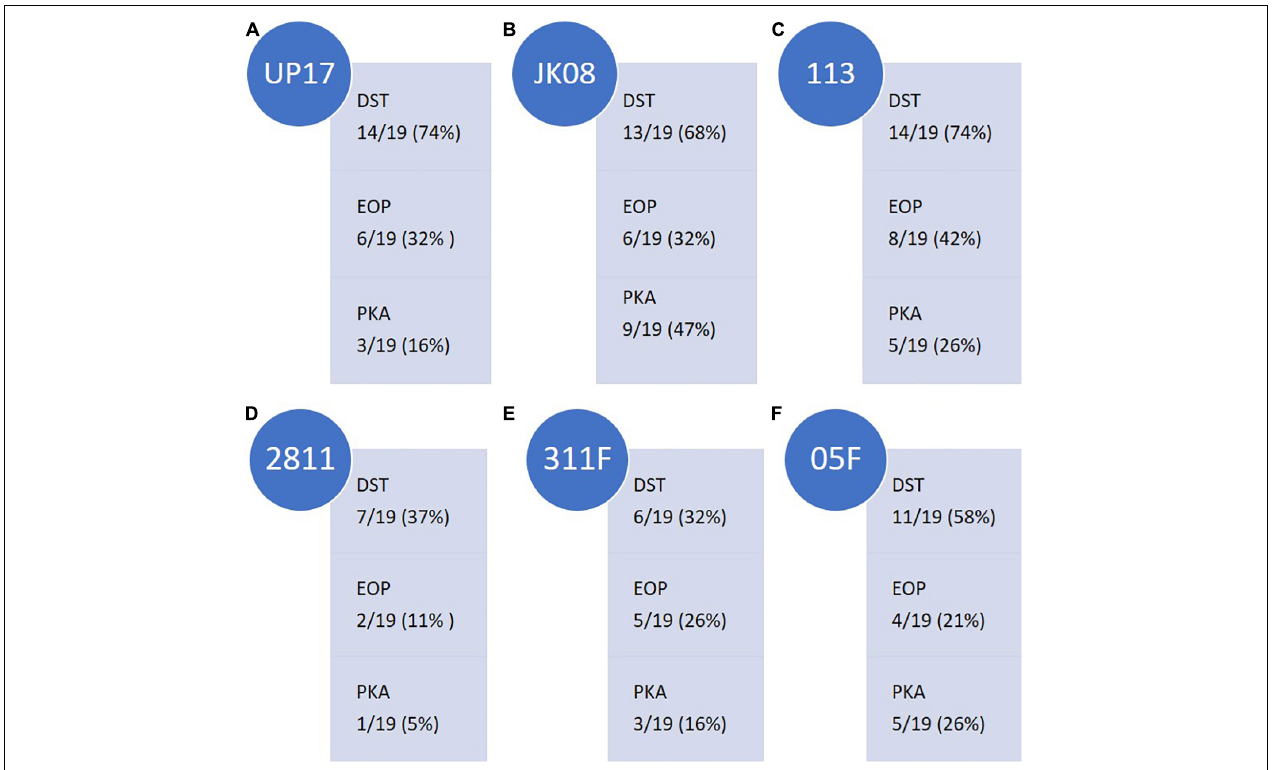
FIGURE 1 | Summary of the ESBL-producing E.coli clinical isolate ( n = 19) coverage of final E.coli phages (A) UP17, (B) JK08, and (C) 113 and ESBL-producing Klebsiella clinical isolate ( n = 19) coverage of final Klebsiella phages (D) 2811, (E) 311F, and (F) 05F across the three selection tests [Direct Spot Test (DST), Efficiency of Plating (EOP) and Killing (Planktonic Killing Assay)]. Isolate coverage was determined by the following parameters: DST ≥ + appearance score; EOP > 0.01; Killing ≥ 0.2 virulence index